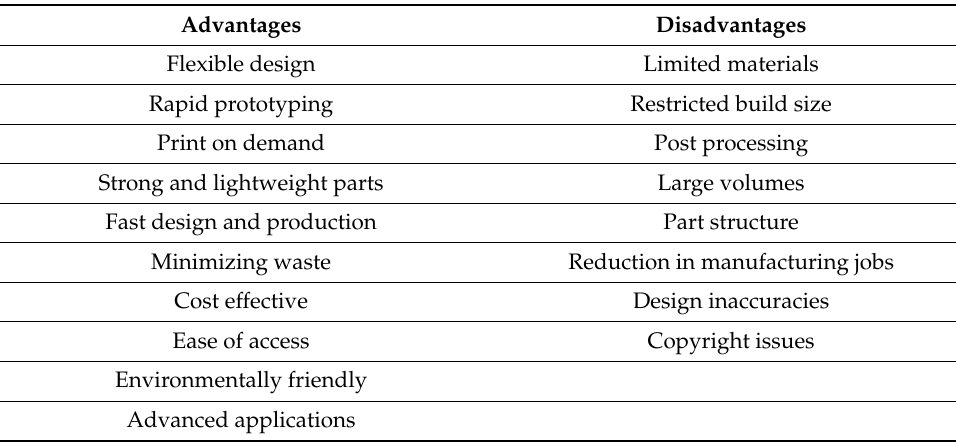
Table 1. Advantages and disadvantages of 3D printing.